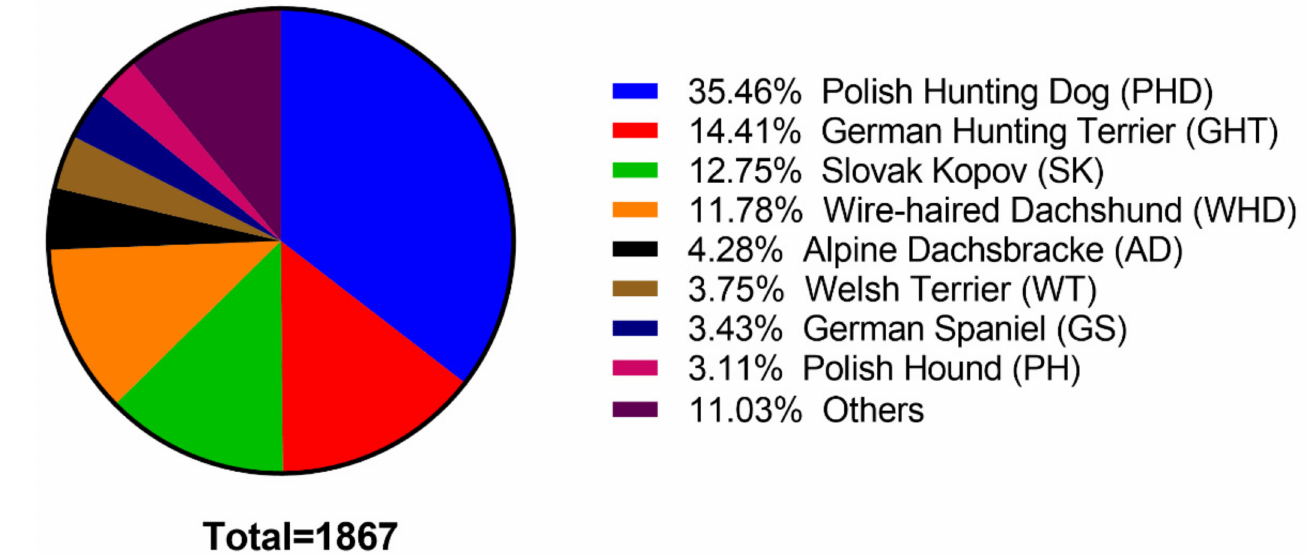
Figure 2. Breed distribution of the boarhound